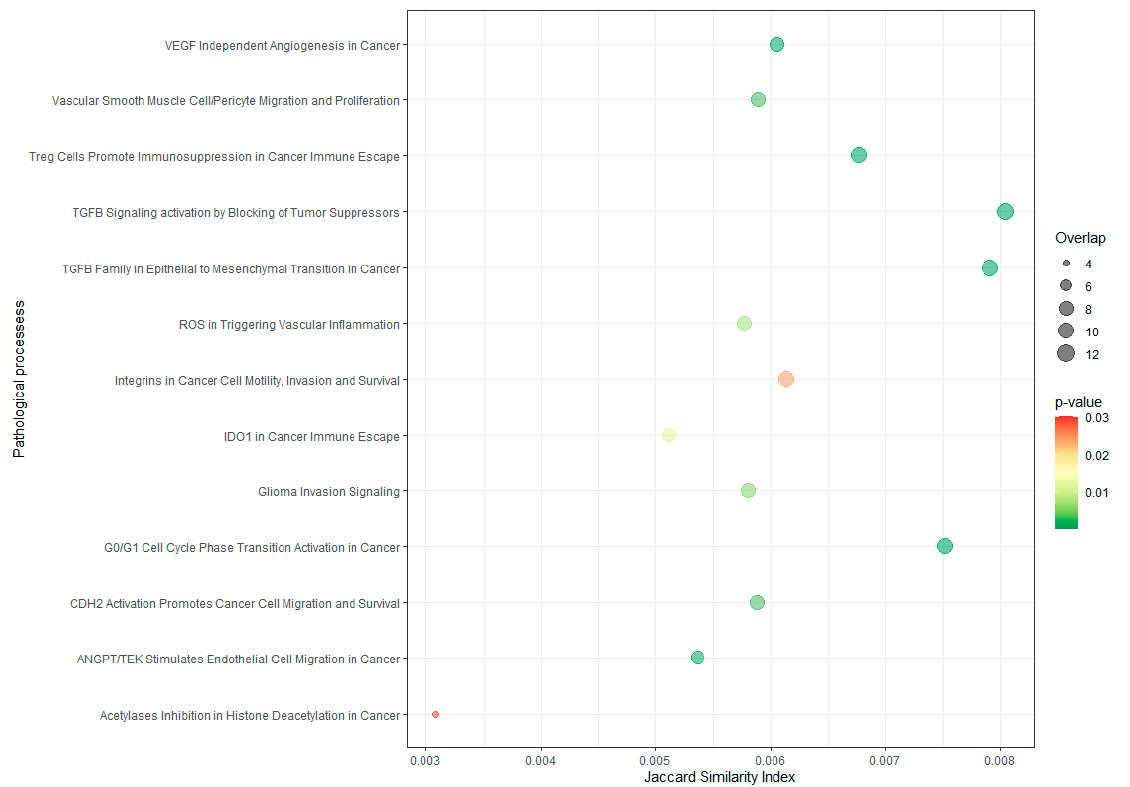
Figure 4. Pathological process enrichment in differentially expressed genes seen in tumor culture- derived exosomes. Y axis indicates the name of the pathological process and X axis indicates the Jaccard similarity index (JSI). The bubble size indicates the number of overlapped genes for each process. The color bar indicates the p -value, representing in red the highest value (0.03), whereas values lower than 0.01 are represented in green.